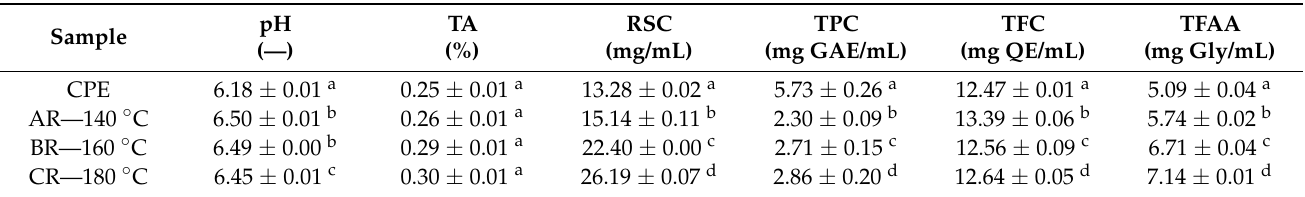
Table 4. The physicochemical changes between the initial and the reconstituted